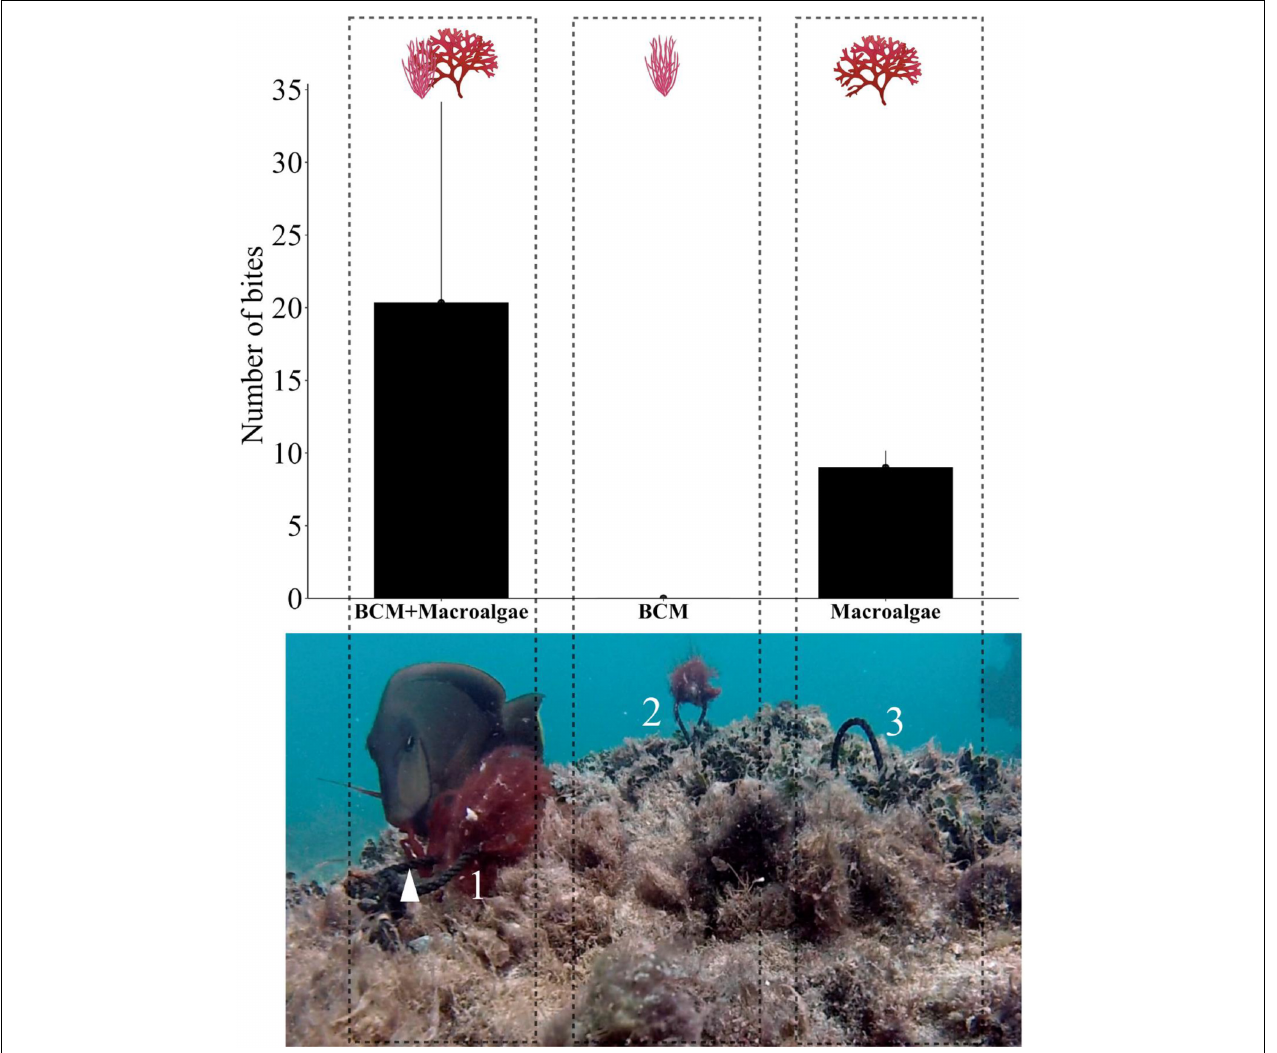
FIGURE 6 | Susceptibility tests of BCMs and palatable macroalgae in single and mixed treatments. Bar plot of the mean number of bites in each treatment ( N = 3), whiskers: standard error. Photo: Acanthurus bahianus biting macroalgae in the mixed treatment (BCMs + macroalgae) during the course of one of the trials when consumption had already taken place, hence the empty rope in the macroalgae-only treatment in 3. The arrow points to the macroalgae thalli. Numbers refer to treatments within each dashed line rectangle: 1 = mixed; 2 = BCMs; 3 = macroalgae. Snapshot from wide-angle footage. Size distortions causing close objects to appear larger than their actual size (please see Supplementary Video